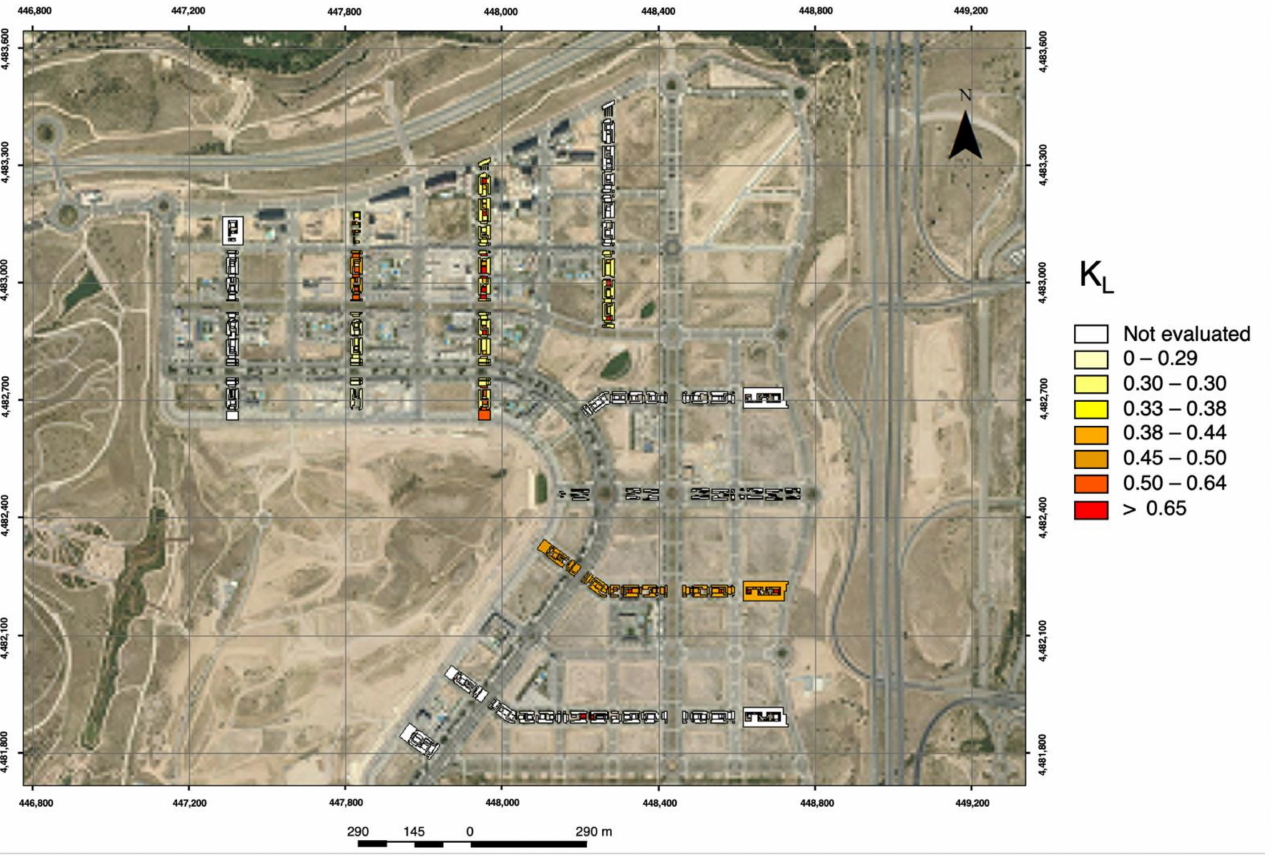
Figure 6. Maps for hydrozones in parks 301, 302, and 303 show the average KL coefficient for the irrigation seasons from 2017 to